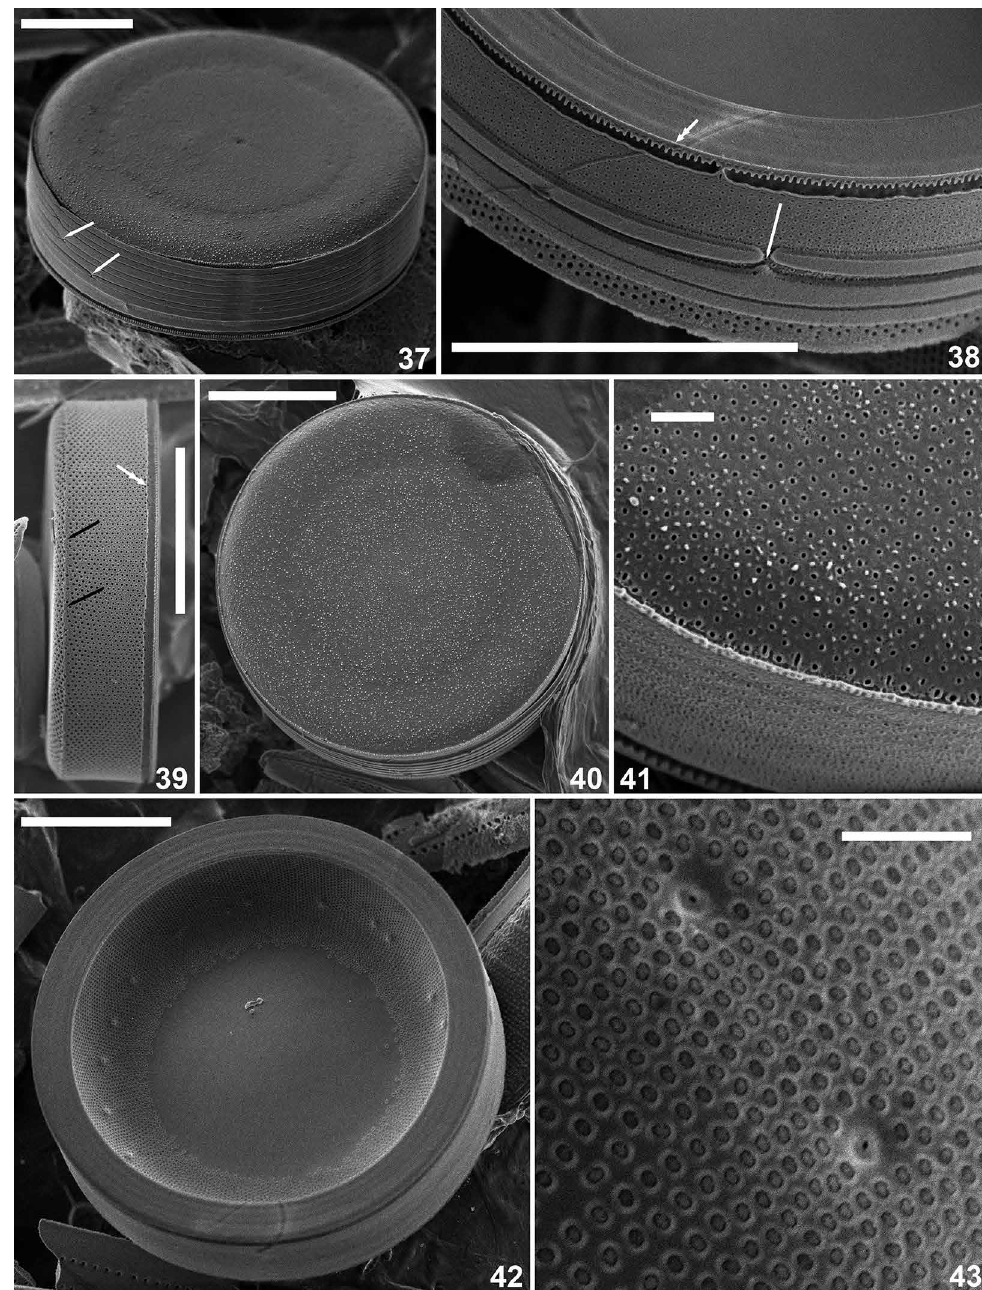
Figs 37–43. Angusticopula cosmica Goeyers & Van de Vijver sp. nov. SEM. Campbell Island holotype population, sample BAS303 (BR-4577). 37 . Frustule showing both the valve face and girdle formed by open, narrow copulae. The arrows indicate the ligulae. 38 . Detail of the mantle valve with the serrated mantle edge (double arrow) and the ligulate copulae (single arrow). 39 . Valve in girdle view showing the striated mantle, the narrow ridge bordering the mantle/valve face junction (black arrows) and the typical groove bordering the mantle edge (double white arrow). 40 . External view of a valve face showing the dense pattern of granules. 41 . External detail of the very fine striae, the small, rounded areolae and the narrow ridge bordering the valve margin. 42 . Internal view of an entire valve showing the rimoportulae and the thick mantle. 43 . Internal detail of the valve with some rimoportulae. Scale bars: 37–39, 42 = 10 μm; 40 = 5 μm; 41, 43 = 1